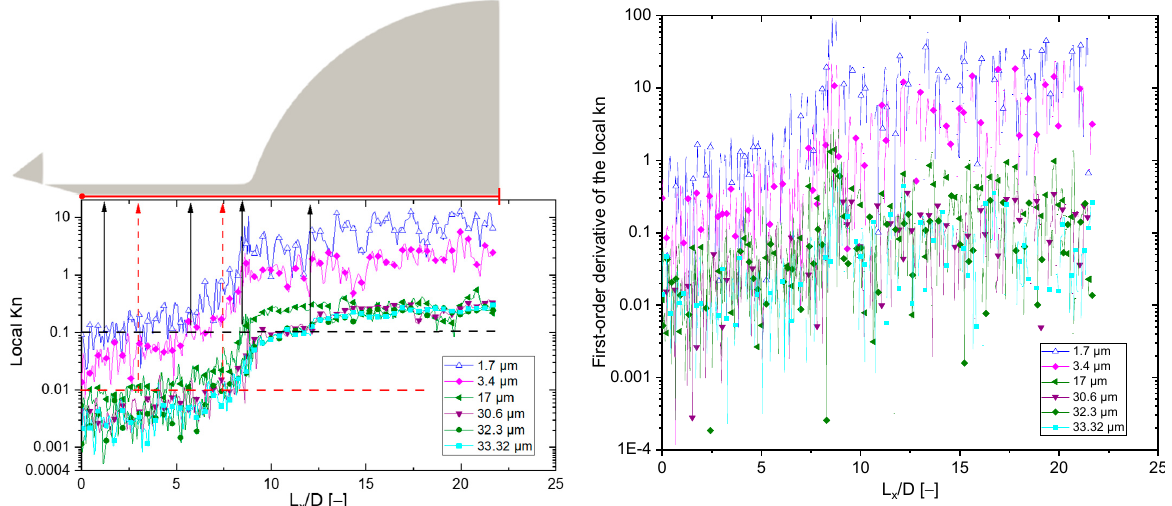
Figure 14. Local Kn distributions along the axis with different valve opening ratios (Left-side image). First-order derivative of the local Kn number is shown in right-side image. The partition interface between the slip flow and the transition flow region (Kn = 0.1). If Kn is less than 0.01, the nitrogen gas flow is in the continuous flow regime.